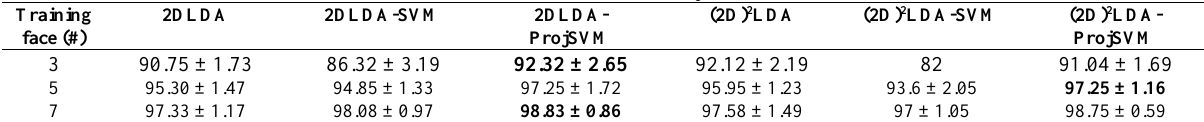
Table 4. Mean classification accuracy (in percent) over 10 random runs for ORL dataset with reduced dimension of 10 using 2DLDA and (2D) 2 LDA as dimensionality reduction methods.